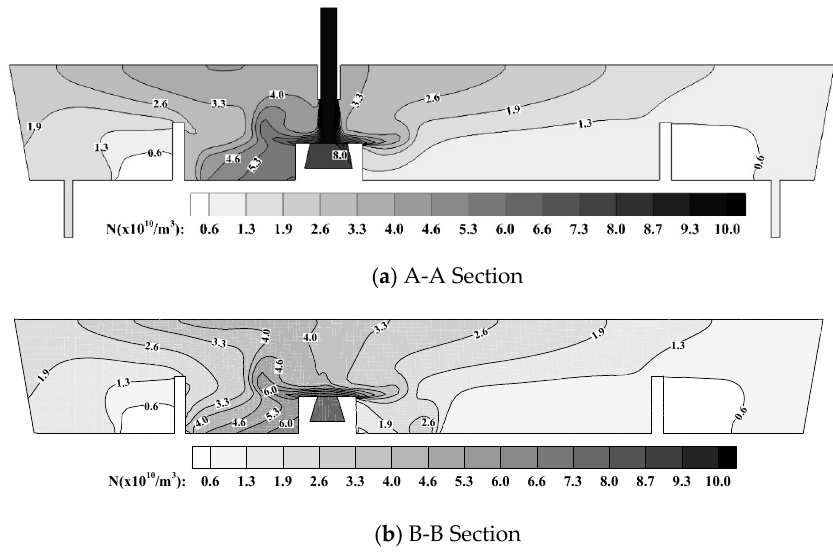
Figure 14. Characteristic inclusion number density in the original tundish.